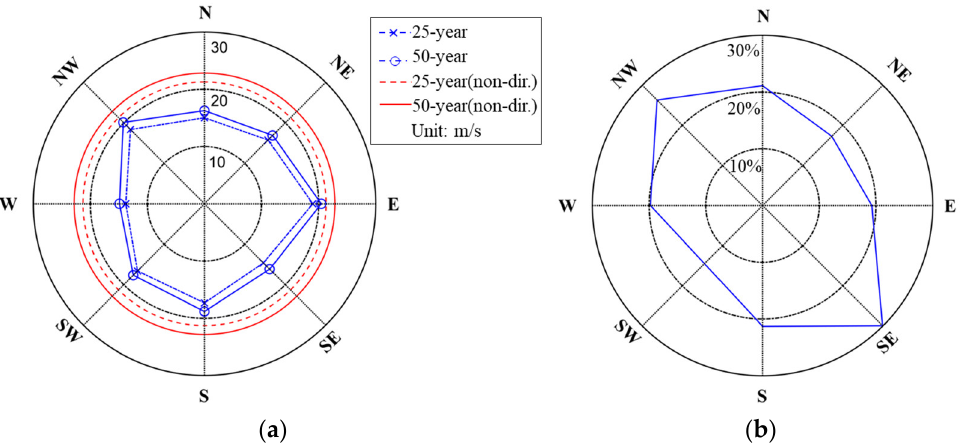
Figure 1. Extreme wind speeds with different MRIs and the CoV along each direction in Jinan, China: ( a ) Wind speeds of different MRIs; ( b ) CoV.